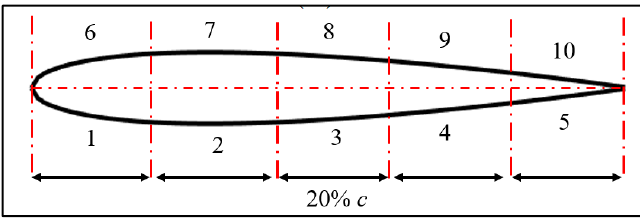
Figure 2. Zone divisions on NACA 0012 wall.